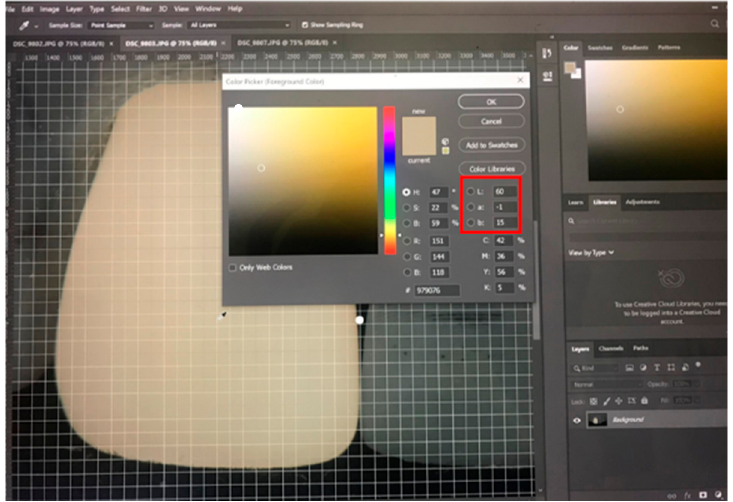
Figure 5. Data collection (L, a, and b value) on a cropped photograph in Adobe Photoshop 2020 for shade